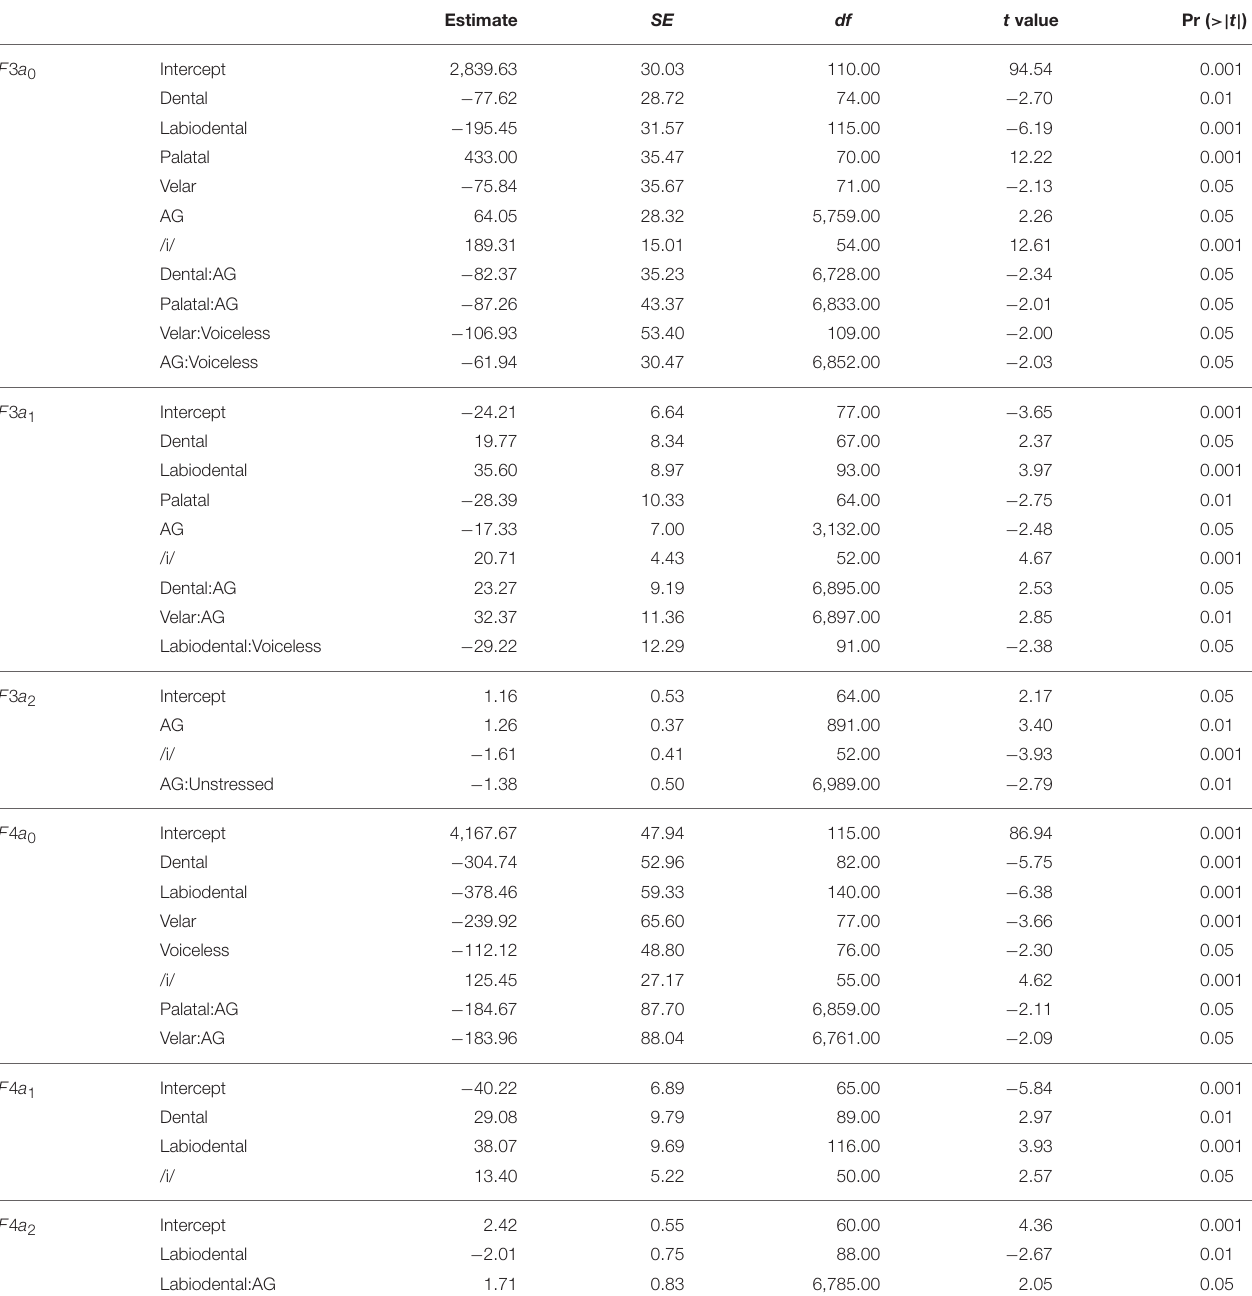
TABLE 9 | Effects of dialect [Athenian Greek (AG) and Cypriot Greek (CG)], place of articulation, voicing, stress, and vowel on the three polynomial coefficients of F 3 and F 4. Estimate SE df t